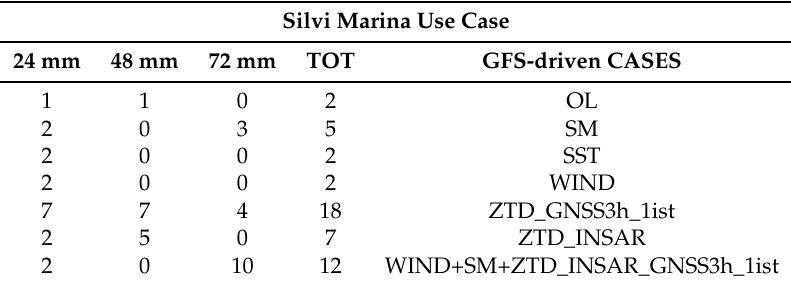
Table A10. Summary of the sensitivity performances (GFS-driven cases). The times in which each forecast has the best result for each score is counted for each threshold and summarized in a total count (summing Tables A7–A9) that is used to find the best simulation.